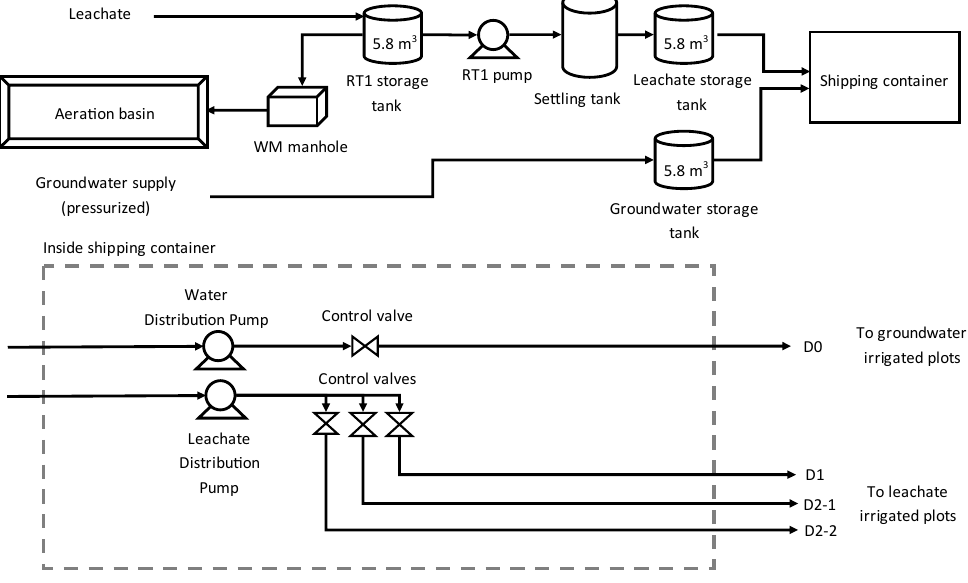
Figure 7. Diagram representing the irrigation system.